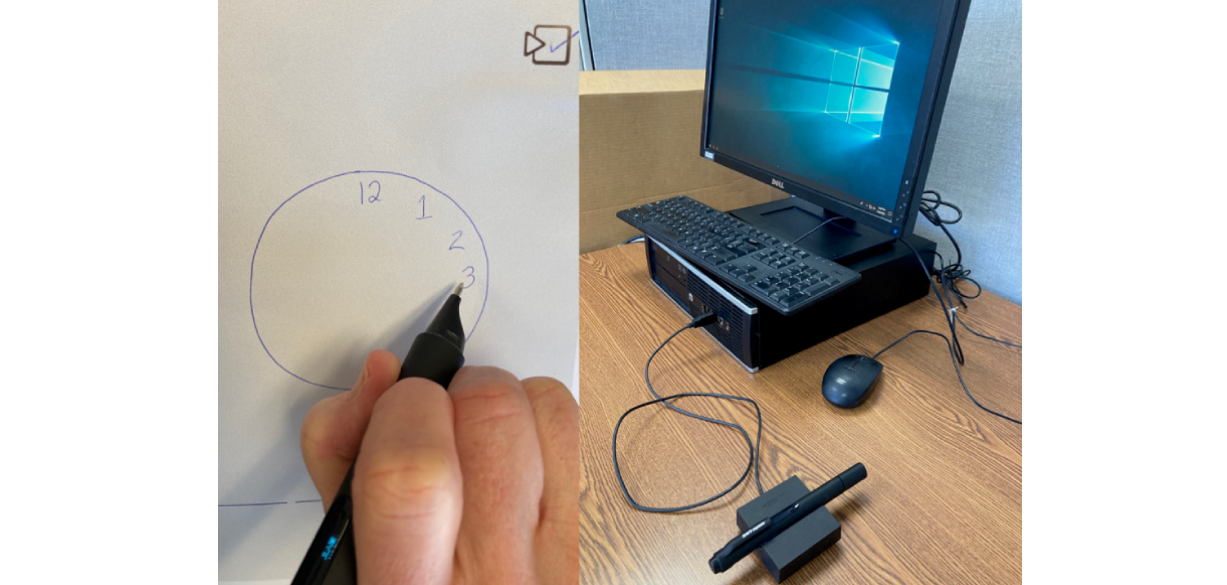
Figure 1. Digital Clock Drawing Test digital pen, smart paper, and docking